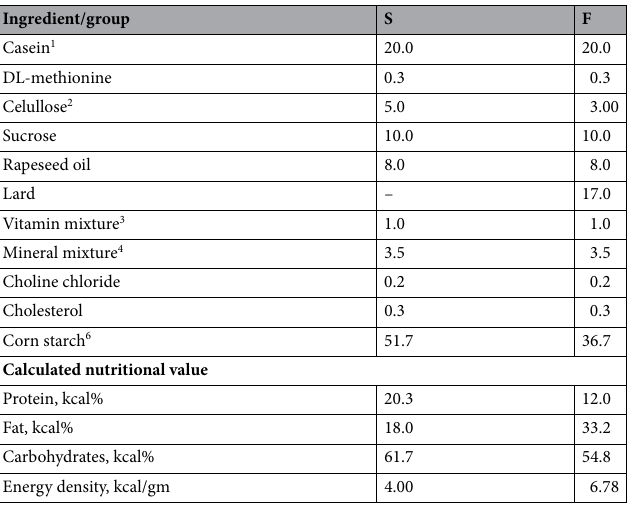
Table 7. Composition of diets fed to rats (%). 1 Casein preparation (LACPOL Co., Murowana Goslina, Poland), crude protein 89.7%, crude fat 0.3%, ash 2.0% water 8.0%. 2 α-cellulose (SIGMA. Poznan. Poland)— main source of dietary fibre. 3 AIN-93G-VM 28 ; g/kg mix: 3.0 nicotinic acid, 1.6 Ca pantothenate, 0.7 pyridoxine–HCl, 0.6 thiamine-HCl, 0.6 riboflavin, 0.2 folic acid, 0.02 biotin, 2.5 vitamin B 12 (cyanocobalamin, 0.1% in mannitol), 15.0 vitamin E (all-rac-α-tocopheryl acetate, 500 IU/g), 0.8 vitamin A (all-trans-retinyl palmitate, 500 000 IU/g), 0.25 vitamin D 3 (cholecalciferol, 400 000 IU/g), 0.075 vitamin K 1 (phylloquinone), 974.655 powdered sucrose. 4 Mineral mix; g/kg mix: 357 calcium carbonate anhydrous CaCO 3 , 196 dipotassium phosphate K 2 HPO 4 , 70.78 potassium citrate C 6 H 5 K 3 O 7 , 74 sodium chloride NaCl, 46.6 potassium sulphate K 2 SO 4 , 24 magnesium oxide MgO, 18 microelement mixture 5 , starch to 1 kg = 213.62. 5 Microelement